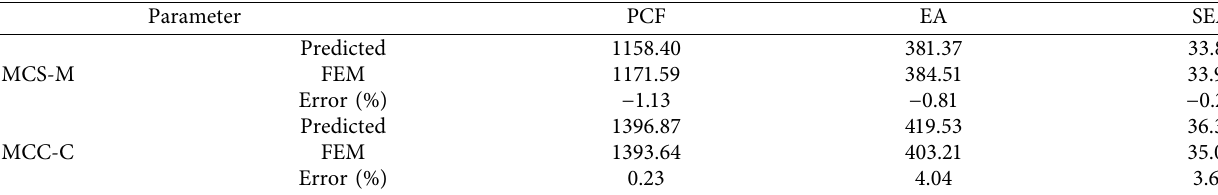
Figure 15: Improvement in the crashworthiness of different windowed structures under the optimal PCF. (a) PCF. (b) SEA. Table 8: Verification of optimal